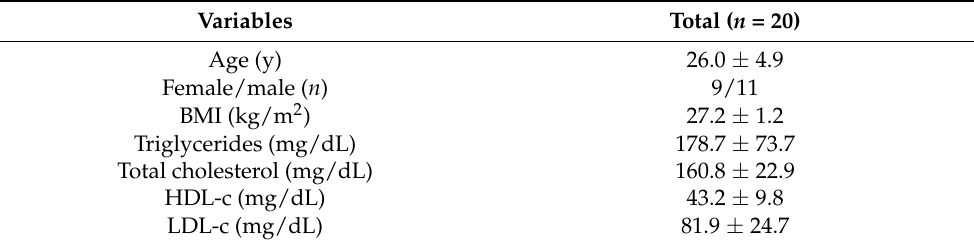
Figure 4. Participant flow diagram. CBBS, common bean baked snack. Table 2. The baseline characteristics of the study participants 1 .